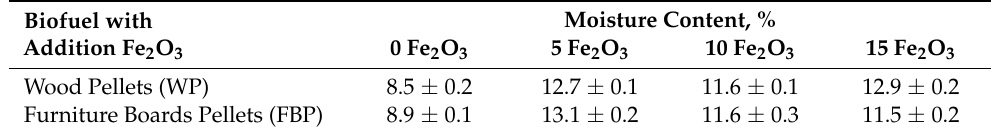
Table 4. Pellet moisture content.